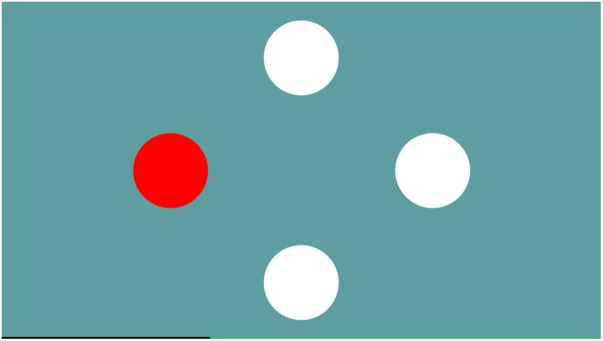
The game Simple trains focussed attention – the ability to concentrate on certain stimuli and react as quickly as possible to them.